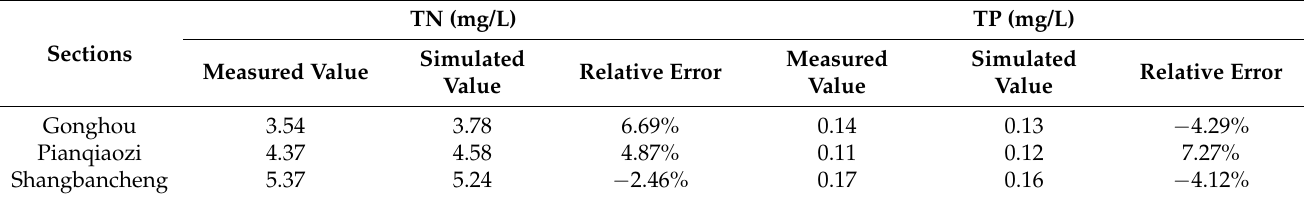
Table 7. Error statistics of TN and TP simulation results of the MIKE11 water quality